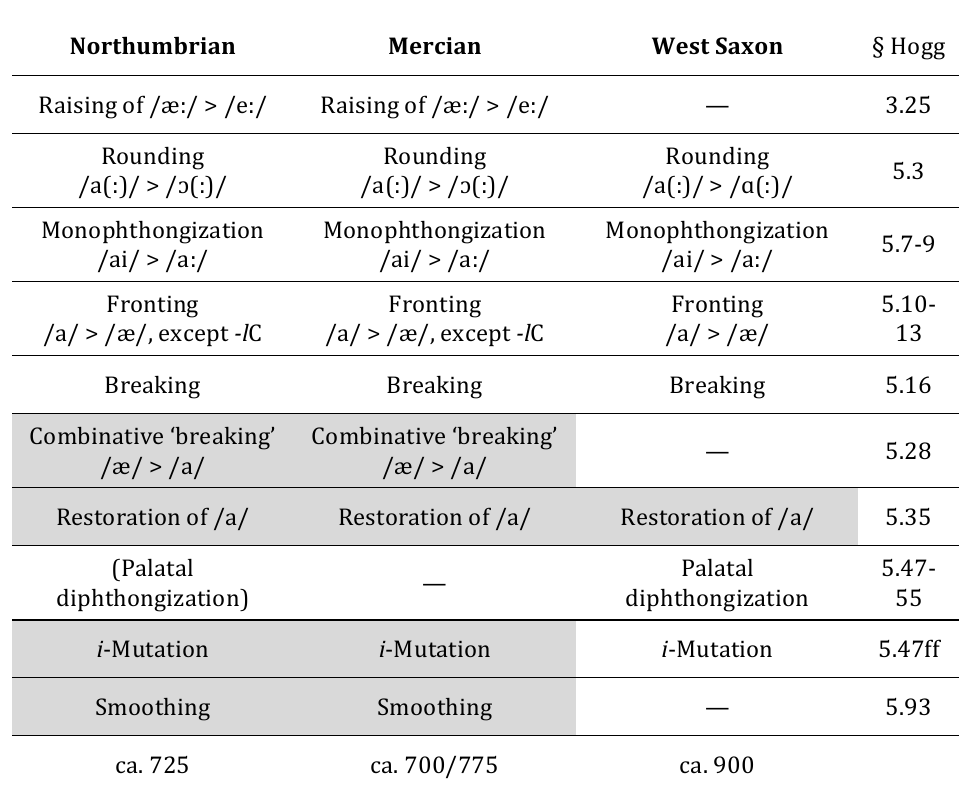
Table 1 : Sound laws for Early Old English per dialect according to the Standard Theory. The sound laws marked with grey background reverse the effects of fronting or